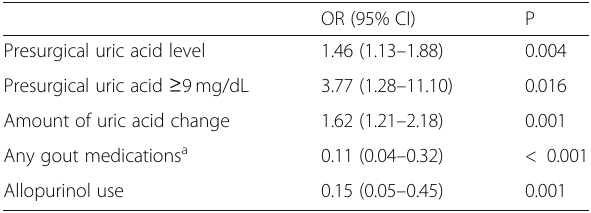
Table 4 Univariate analysis for risk factors of postsurgical gout flare